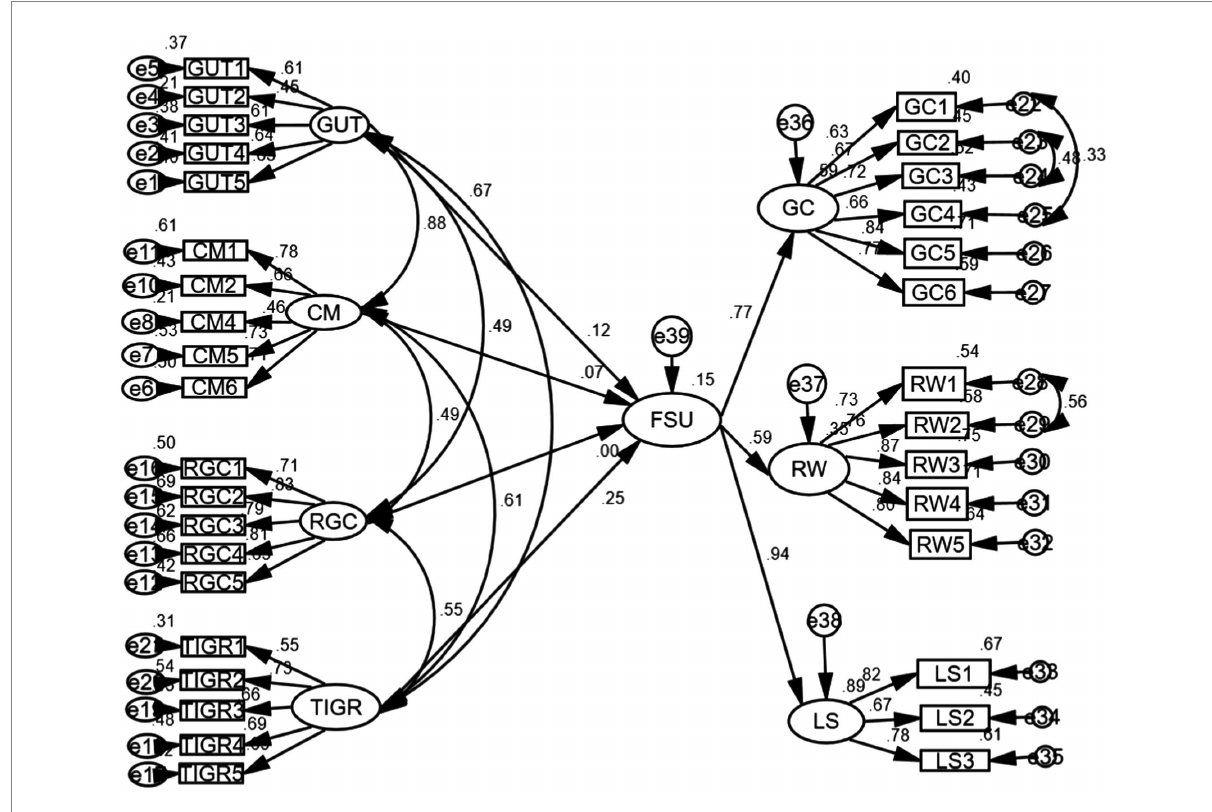
FIGURE 4 The SEM results of digital nativity and favorable Smartphone